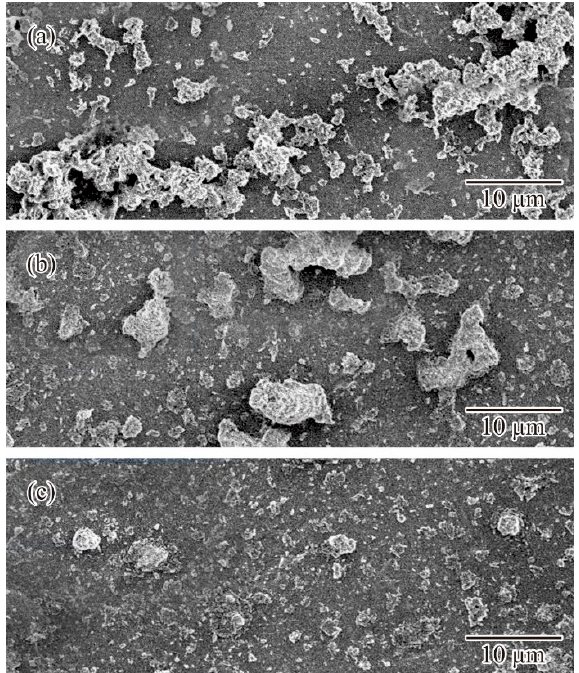
Figure 6. Alumina particles dispersed in acrylic resin. Paste containers were rotated and revolved for processing times of 300, 600, and 900 s. Cross sections of solid films are shown in ( a – c ).